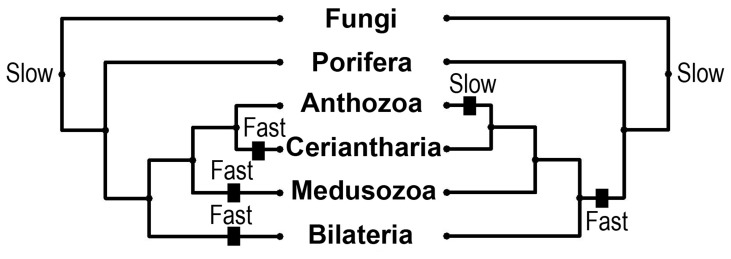
Graphic representation of possible evolutionary scenarios for slow mtDNA evolution in Anthozoa, modified from [39].Scenario A: fast evolution originated in the Ceriantharia, Medusozoa and Bilateria independently (adapted from [43]). Scenario B: fast mtDNA evolved as a unique event (Cnidaria+Bilateria) but was subsequently lost in Anthozoa (not including Ceriantharia).